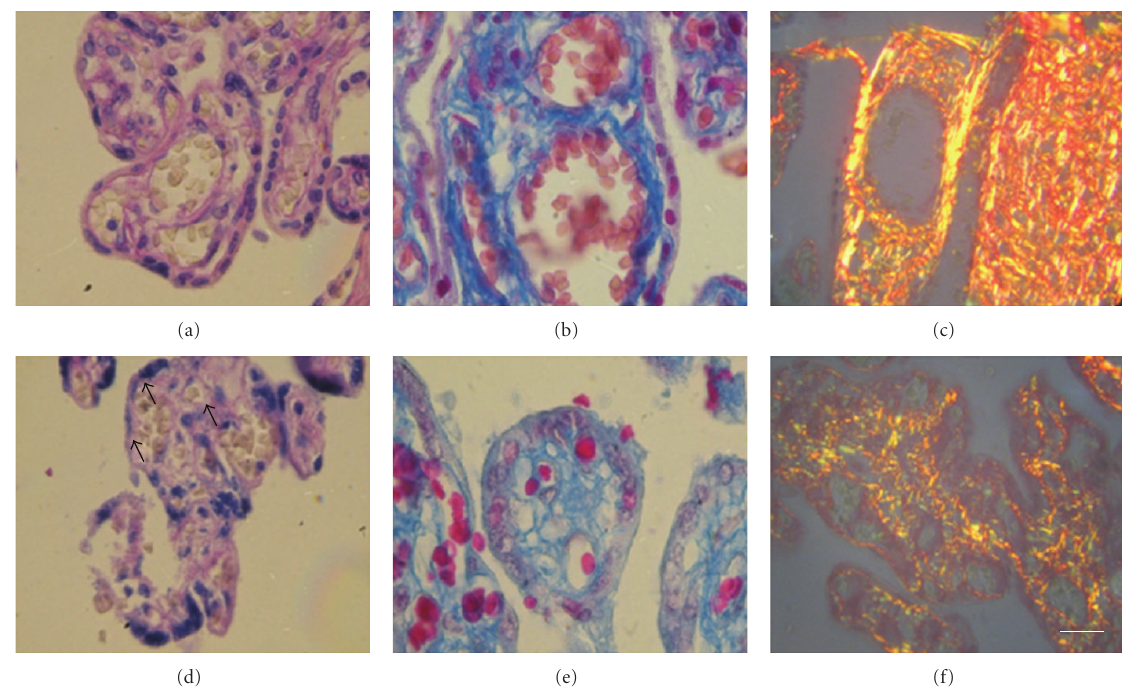
Figure 4: Placentas from mothers infected with T. cruzi present severe disorganization of chorionic villi ECM . Placental tissue from healthy noninfected (a–c) and infected (d–f) women were processed for routine histochemical methods and stained with the PAS method for the detection of glycosylated components (a, d) with the Arteta trichromic (b, e), and picrosirius red-hematoxylin (c, f) methods for collagen histochemistry. Placental chorionic villi from infected mothers show reduced staining of glycosylated molecules (d), especially in basal lamina (arrows) compared to controls (a). Samples from infected mothers also show reduced histochemical reaction for collagen in basal lamina (e) and in villous stroma (f) compared to controls (b, c). Bar scale: 20 μ